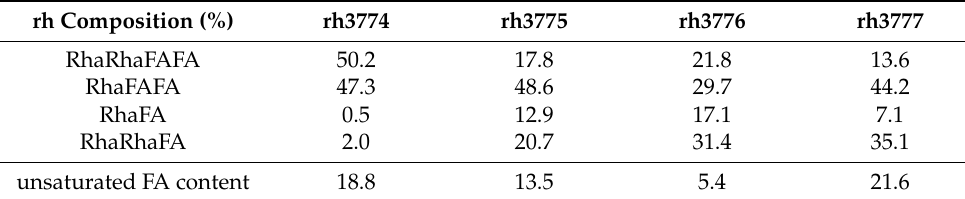
Table 1. Total relative content of rhamnolipid congeners in rhamnolipid mixtures (rh) produced by four Pseudomonas aeruginosa strains (DBM 3774, DBM 3775, DBM 3776 and DBM 3777); Rha— rhamnose; FAfatty acid.